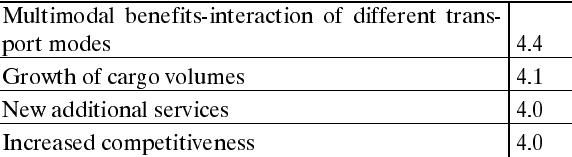
Table 2. Benefits / profits from cooperation with the same type of business companies Multimodal benefits-interaction of different trans- port modes